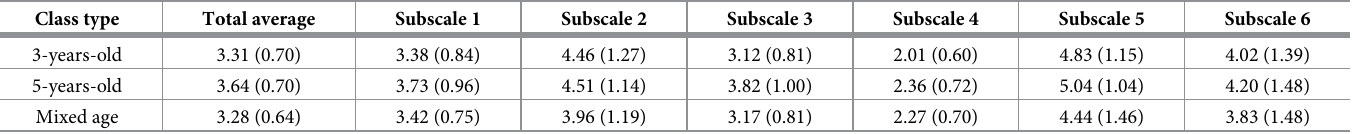
Table 4. The mean total average score and mean scores of total average and each subscale per class age group.